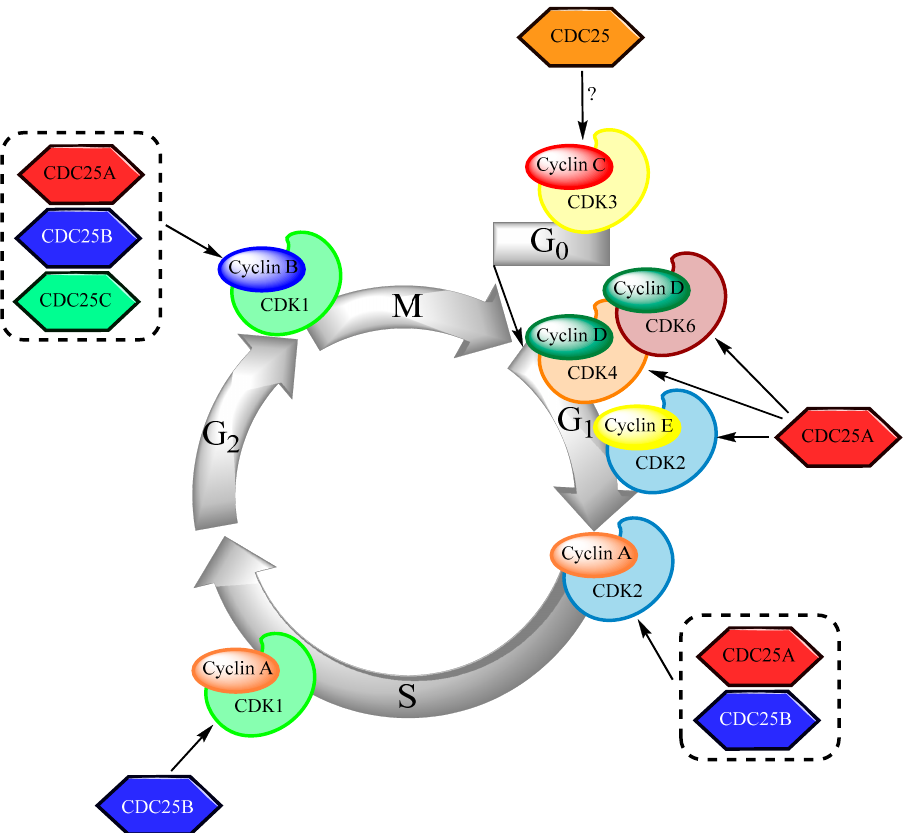
Figure 2. An overview of the regulatory function of CDC25s in cell cycle progression. At G 0 -phase, cells that had been quiescent, re-enter the cell cycle after activation of CDK3/cyclin C. Dephosphorylation of CDK4/cyclin D, CDK6/cyclin D and CDK2 both in complex with cyclin E and cyclin A by CDC25s leads to the transition into the DNA-replication phase. At late S-phase, CDC25B activates CDK1/cyclin A. Finally, dephosphorylation of CDK1/cyclin B triggers mitotic entry, and in this important step all three CDC25 isoforms are involved. At the end of mitosis, both CDK1/cyclin B and the CDC25s are degraded and the cycle can start all over